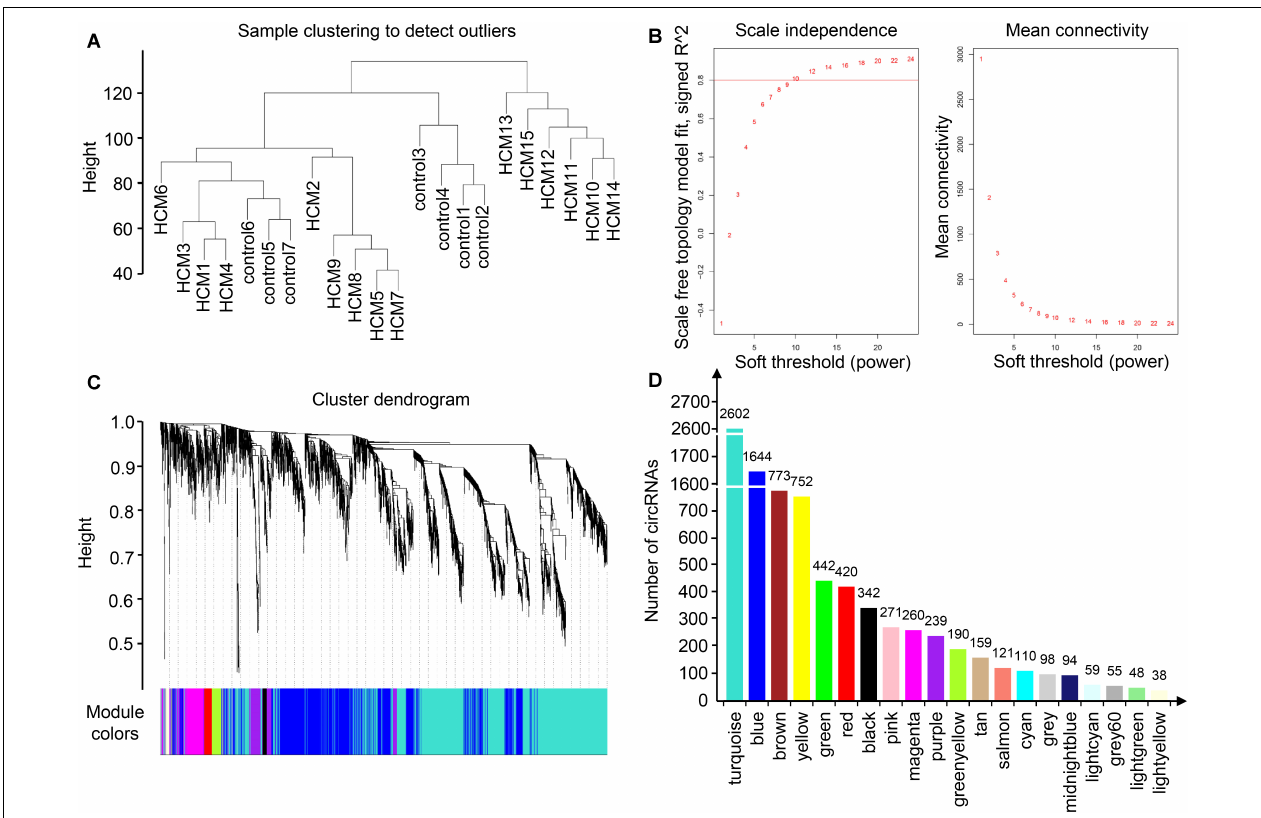
FIGURE 2 | Identification of modules in HCM by WGCNA. (A) Sample clustering to detect outliers. Samples from HCM patients and controls were well distinguished in this dendrogram, indicating the difference of circRNA expression profile. (B) Analysis of network topology for various soft-thresholding powers. Each power corresponded to a scale independence and mean connectivity. A soft threshold of 10 (red horizontal line) was selected for construction of the scale-free topology module. (C) Clustering dendrograms of circRNAs. (D) The number of circRNAs in each module. One module was named with one color, and each color corresponded to a unique module. The number of circRNAs in each module was shown above each column. As a result, 20 coexpression modules were constructed. HCM, hypertrophic cardiomyopathy; WGCNA, weighted gene coexpression network analysis; circRNA, circular